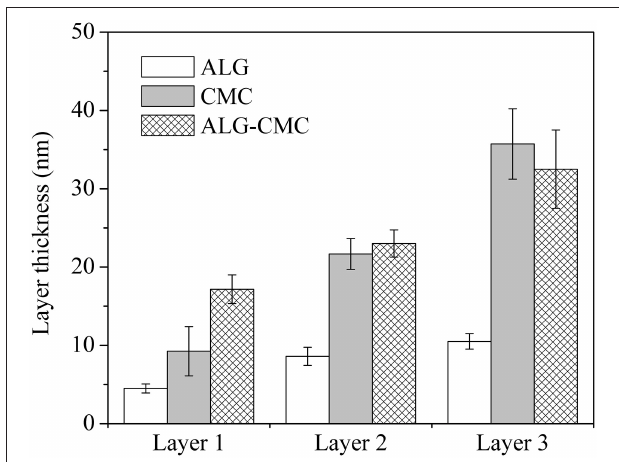
FIGURE 2 | Layer thickness of spin-coated films determined using AFM.